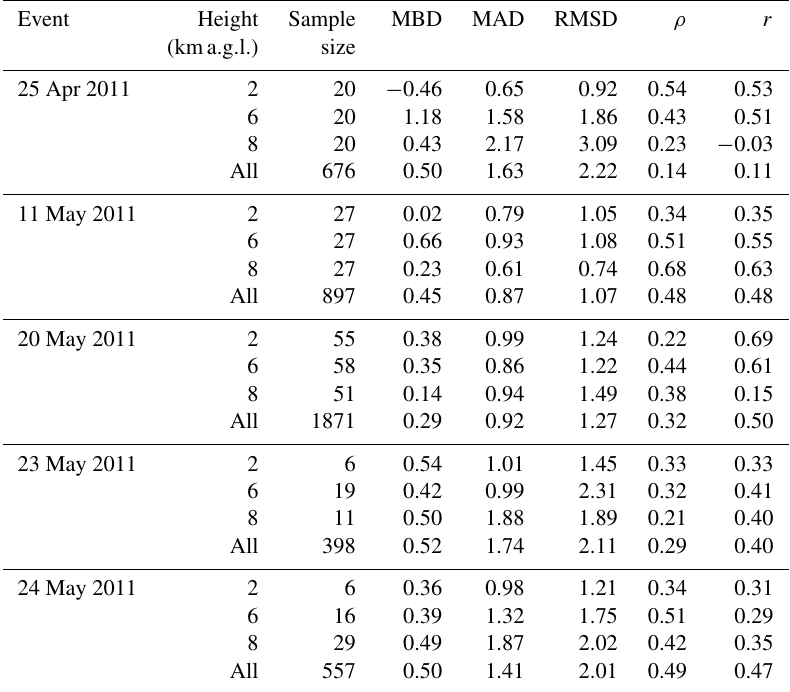
Table 6. Vertical air motion comparisons between 3DVAR and UAZR-C1 at three characteristic heights for all events. Error statistics have units of ms − 1 .